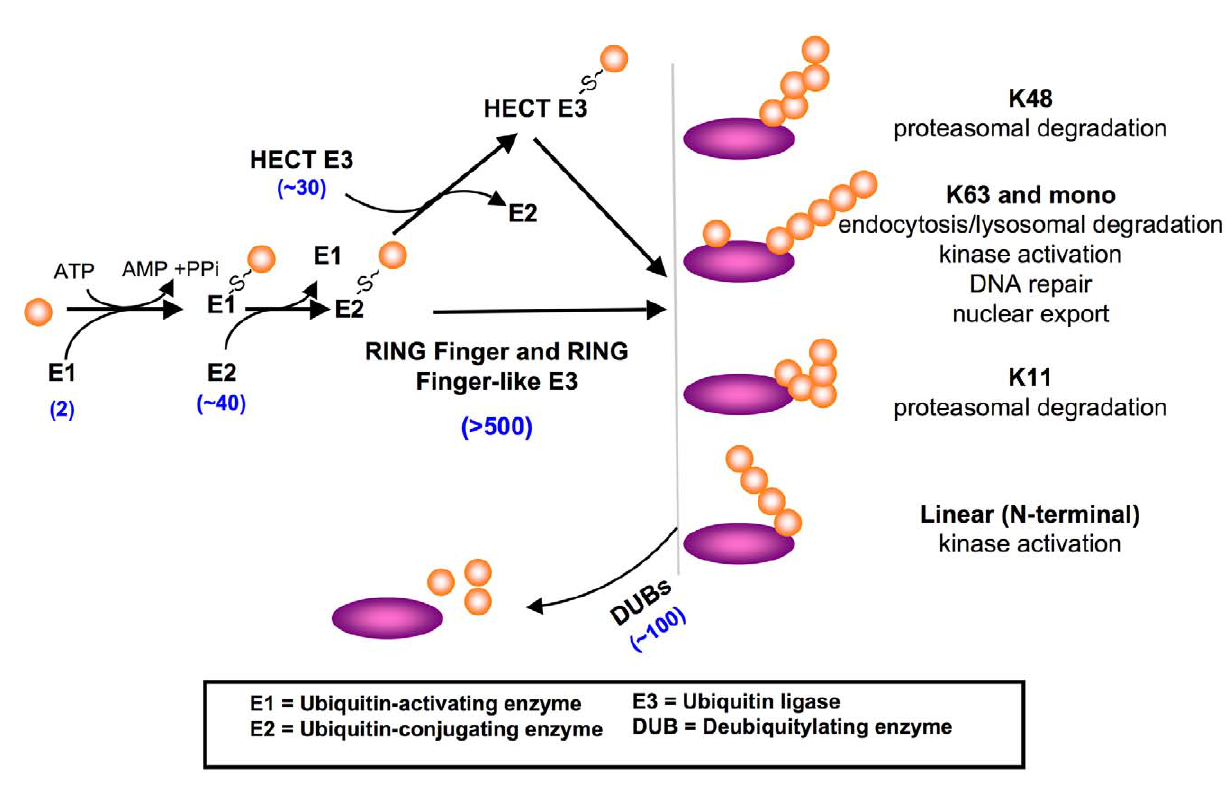
Figure 1. Roles of ubiquitylation in cellular regulation. Conjugation of ubiquitin onto protein substrates requires at least three enzymes. One of two ubiquitin activating enzymes (E1) activates ubiquitin through an ATP-dependent step, forming a thioester linkage between the active site cysteine of E1 and the C-terminal carboxylate of ubiquitin. E1 then transfers the ubiquitin to the active site cysteine of one of approximately 40 mammalian ubiquitin conjugating enzymes (E2). The ubiquitin can be transferred to the active site of a HECT domain ubiquitin ligase (E3), which binds the substrate and mediates the conjugation of ubiquitin. RING finger and related E3s function as allosteric activators of E2, promoting the transfer of ubiquitin directly from the E2 to the substrate. The combination of E2/E3 determines the length and type of polyubiquitin chains assembled on the substrate, which can lead to diverse cellular effects, some of which are noted. Ubiquitylation is best characterized as modifying primary amines (lysines and the N-termini of proteins) [44]. More recently, there has been evidence that other nucleophillic amino acids including serine, threonine, and cysteine can also be modified with polyubiquitin chains [45–48]. DUBs perform a number of cellular roles, including removing ubiquitin from specific substrates. There are at least five classes of DUBs, and many DUBs show strong preferences for specific polyubiquitin chain linkages.